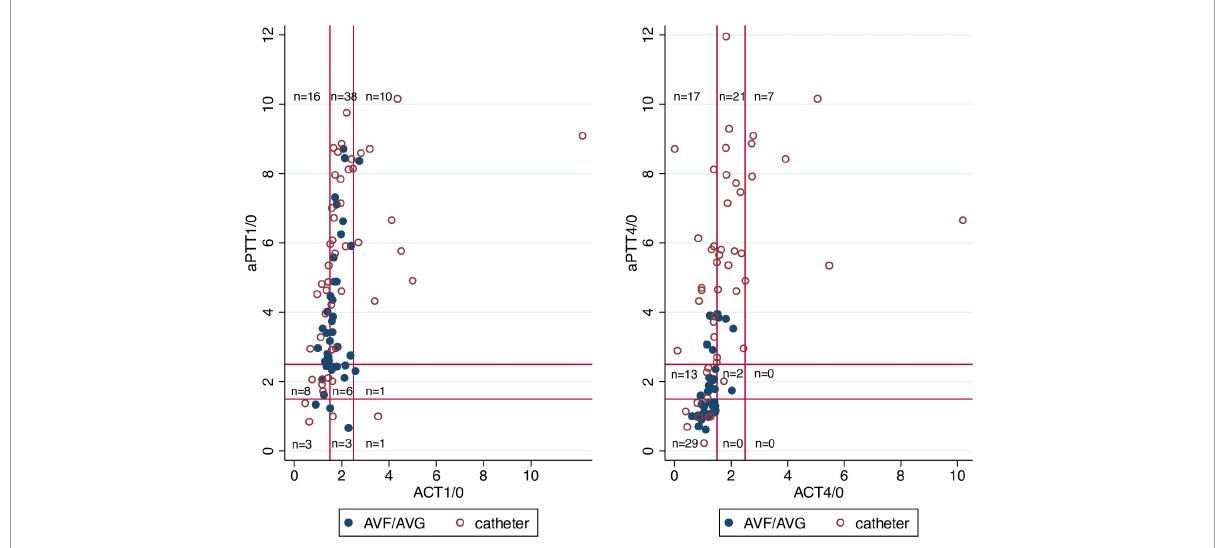
FIGURE4 Relation between aPTT and ACT ratios both 1 h (left panel) and 4 h (right panel) after dialysis start. The red horizontal and vertical reference lines represent the ACT and aPTT ratios of × 1.5 and × 2.5, defining the therapeutic range of anticoagulation. The blue dots represent patients with an arteriovenous fistula or graft, the red circles represent patients with a catheter access. The shorter infusion time of unfractionated heparin in case of AVF/AVG use explains the shift toward lower left for AVF/AVG patients in the right graph. aPTT, activated partial thromboplastin time; ACT, activated clotting time; AVF/AVG, arteriovenous fistula/arteriovenous